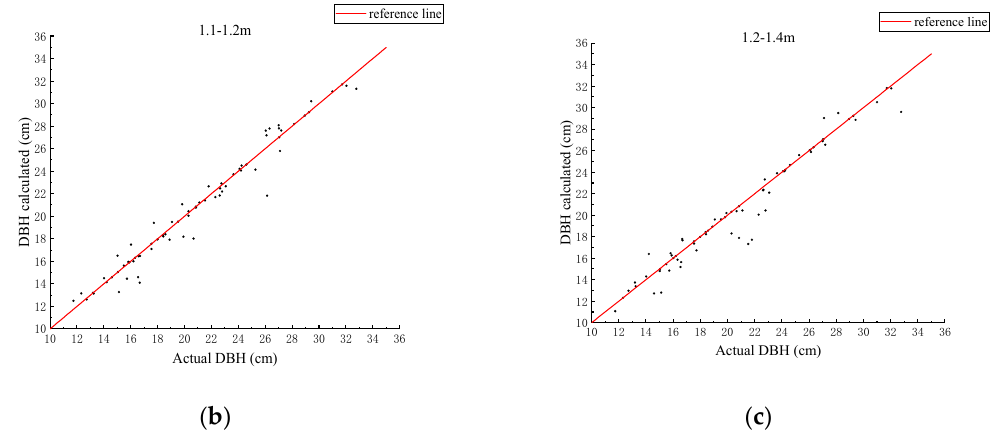
Figure 8. Fitting results and true values for different intervals. ( a ) Interval of 1.0–1.1 m; ( b ) interval of